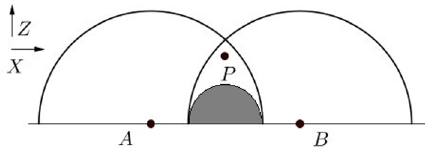
Figure 3 . The fields at point P can be reconstructed using bilocals taken from region A or region B . It is however not possible to reconstruct the bulk fields at point P using bilocals from the intersection A ∩ B . This is simply because point P lies outside of the region shaded gray, which shows the bulk points that can be reconstructed from A ∩ B